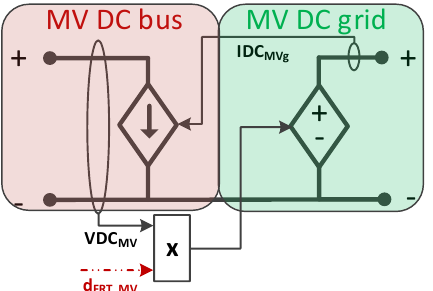
Figure 6. Computational model for the MV DC electronic